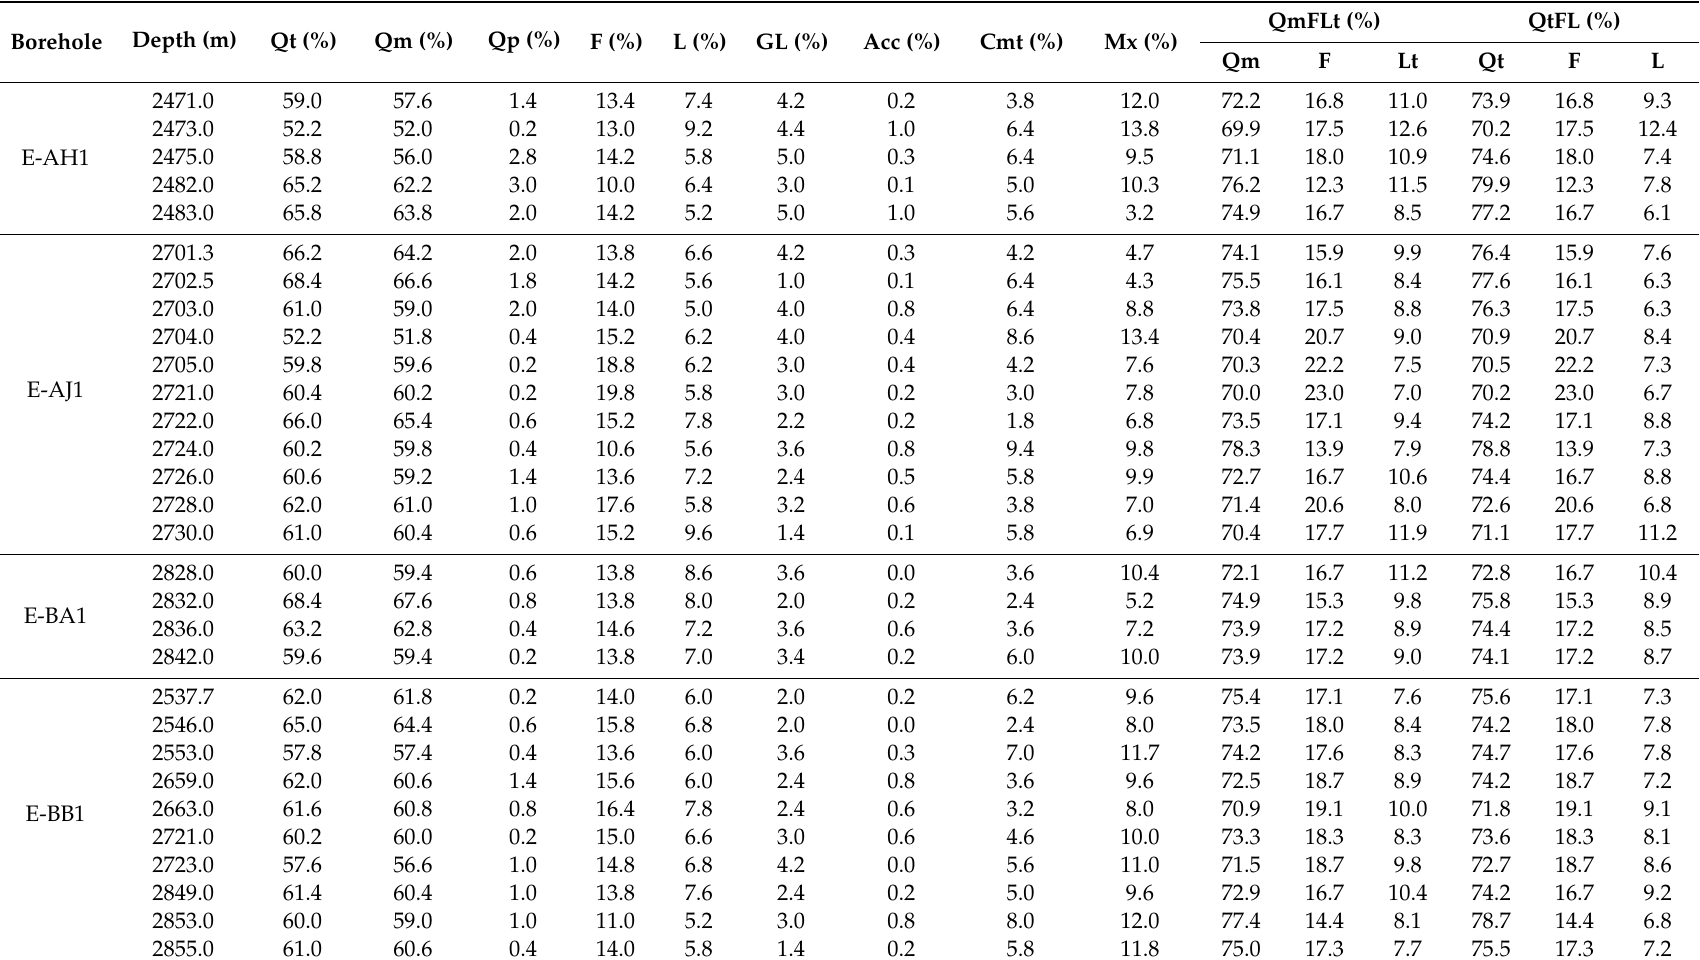
Table 5. Modal compositions of the studied sandstones from the Bredasdorp